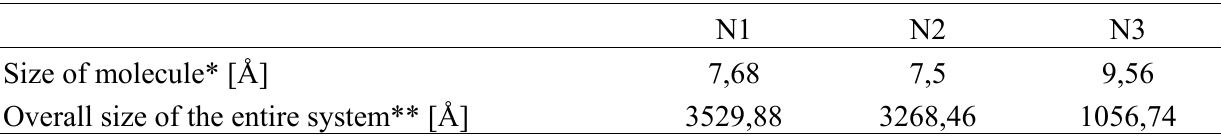
Table 9. Selected geometrical parameters of three different conformations of the